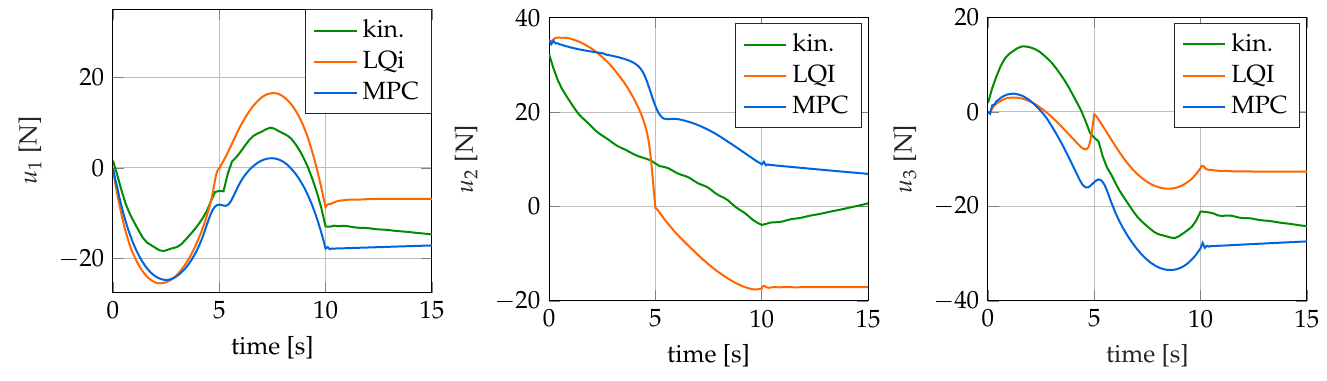
Figure 13. Actuation forces for the swing trajectory over